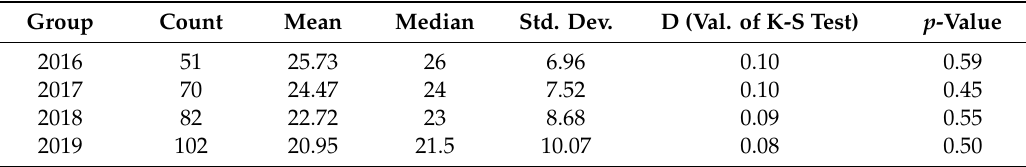
Table 2. Proof of normal